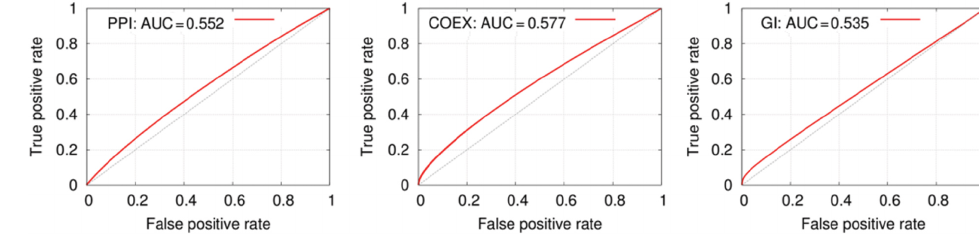
Figure 3: ROC curves indicate a weak separation of the 14 functional groups in GI, COEX and PPI data. We generate the functional organization maps of the three omics dataset as detailed in Section 2.4 (illus- trated in the right panel of Figure 1). The functional communication lines that we obtain in each omics data have differently structured organization, as shown by different clusters in the functional organization maps of PPI, COEX and GI data (blue clusters in the first three heat maps in Figure 4). We find that the strongest func- tional links in the COEX data are between Signalling/stress response, DNA replication repair/HR/cohesion and Golgi/endosome/vacuole sorting, while GI data shows the strongest links between Cell polarity/mor- phogenesis and Protein folding glycosylation/cell wall. In the PPI data, the strongest connections are between Cell polarity/morphogenesis, Protein degradation/proteosome and Chromatin/transcription. All these are